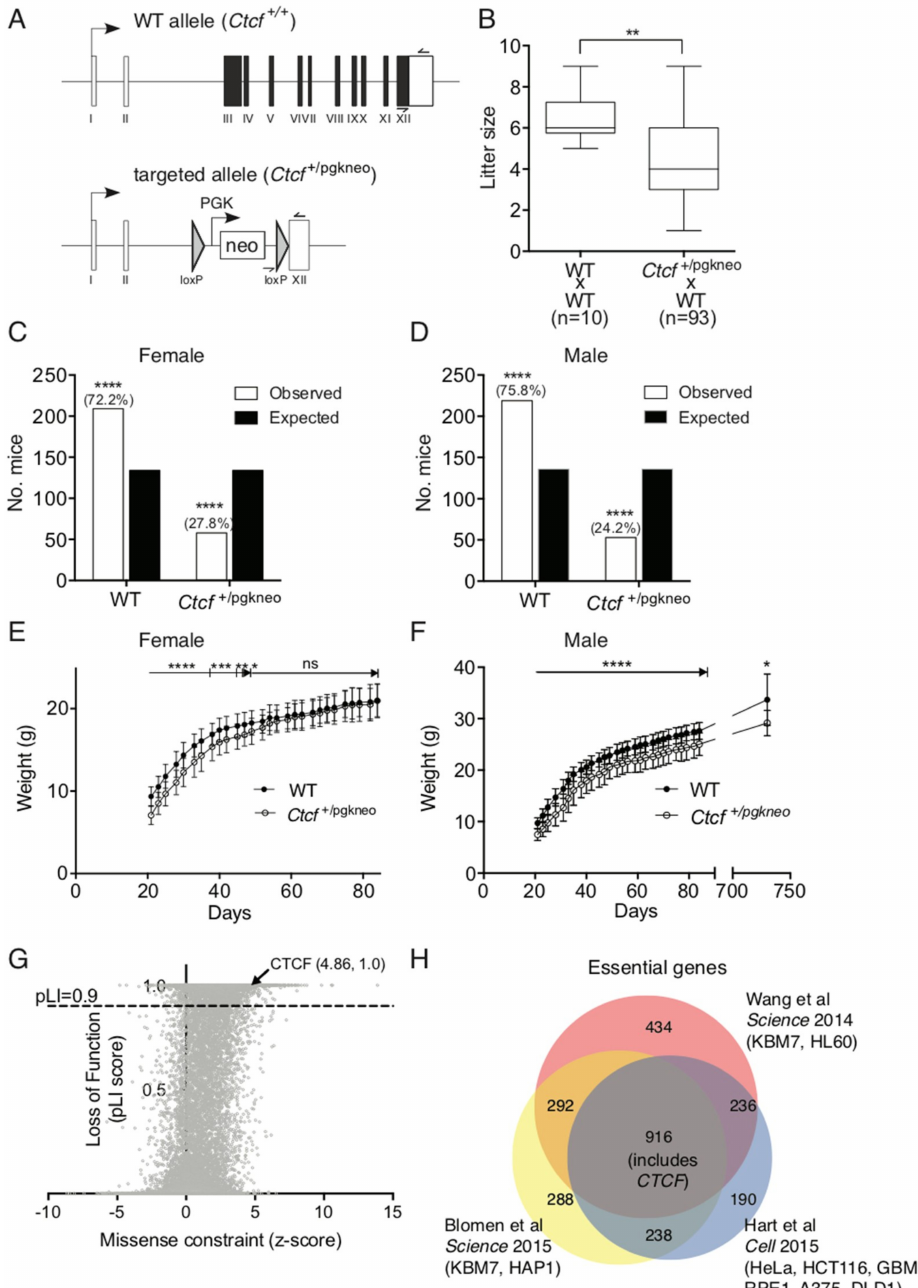
Figure 3. CTCF haploinsufficiency phenotype in mice and humans. ( A ) Schematic of targeted inactivation of Ctcf in mice. Open boxes represent untranslated regions, filled boxes represent coding region. Genotyping primers used to distinguish alleles are indicated with half-arrowheads. Litter sizes ( B ), and Mendelian ratios (%, in brackets) of female ( C ) and male ( D ) pups born from WT x Ctcf +/pgkneo intercrosses. Weights of pups during development following weaning at day 21 (mean ± SD): ( E ) for female; and, ( F ) aged male (>2 yo) mice. ( G ) Analysis of CTCF genetic variation in humans using the ExAC database with pLI > 0.9 indicating intolerance to heterozygous loss-of-function variation. The missense constraint is a measure of the deviation away from the observed variants in a gene versus the expected variants (high positive z-scores indicated intolerance to variation). ( H ) Venn diagram of essential genes identified in three independent genetic screens in human cells. Statistical analysis was performed using Fisher’s exact test or Mann-Whitney U-test (ns = not significant, * p < 0.05, ** p < 0.01, *** p < 0.001, **** p <